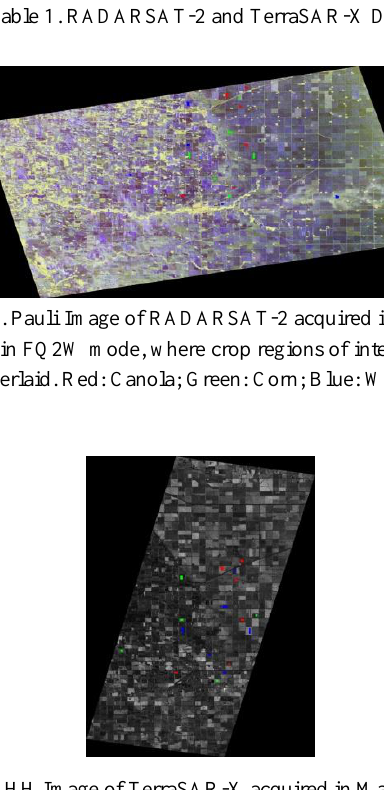
Canola covered the largest area at 1, 295 and 2, 828